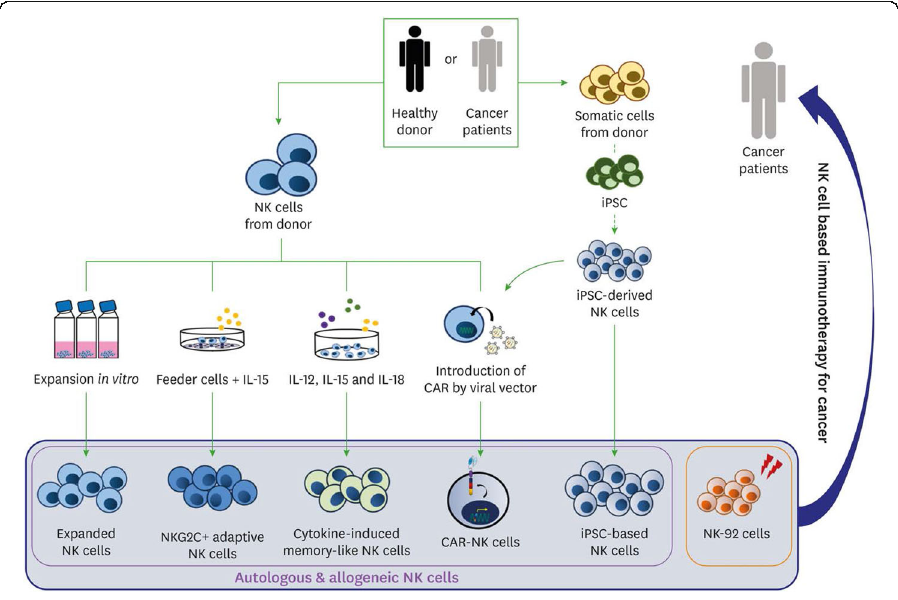
Fig. 1 Methods of NK cell-based immunotherapy for cancer. Types of NK cells used for cancer immunotherapy. Allogeneic NK cells and autologous NK cells, manipulated with cytokines (IL-12, IL-15, and IL-18) and CAR, resulted in various types of NK cells for cancer immunotherapy. Somatic cells from the donor could be used as functional iPSC-based NK cells. Irradiated NK-92 cell line also served as an important resource for NK cell-based cancer therapy (Shin et al.